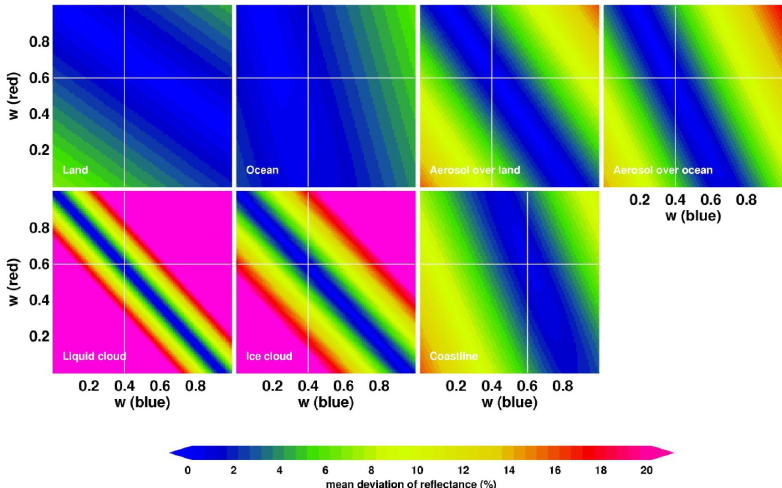
Figure 6b Fig. 6b. Same as in Fig. 7a, but for 8 July